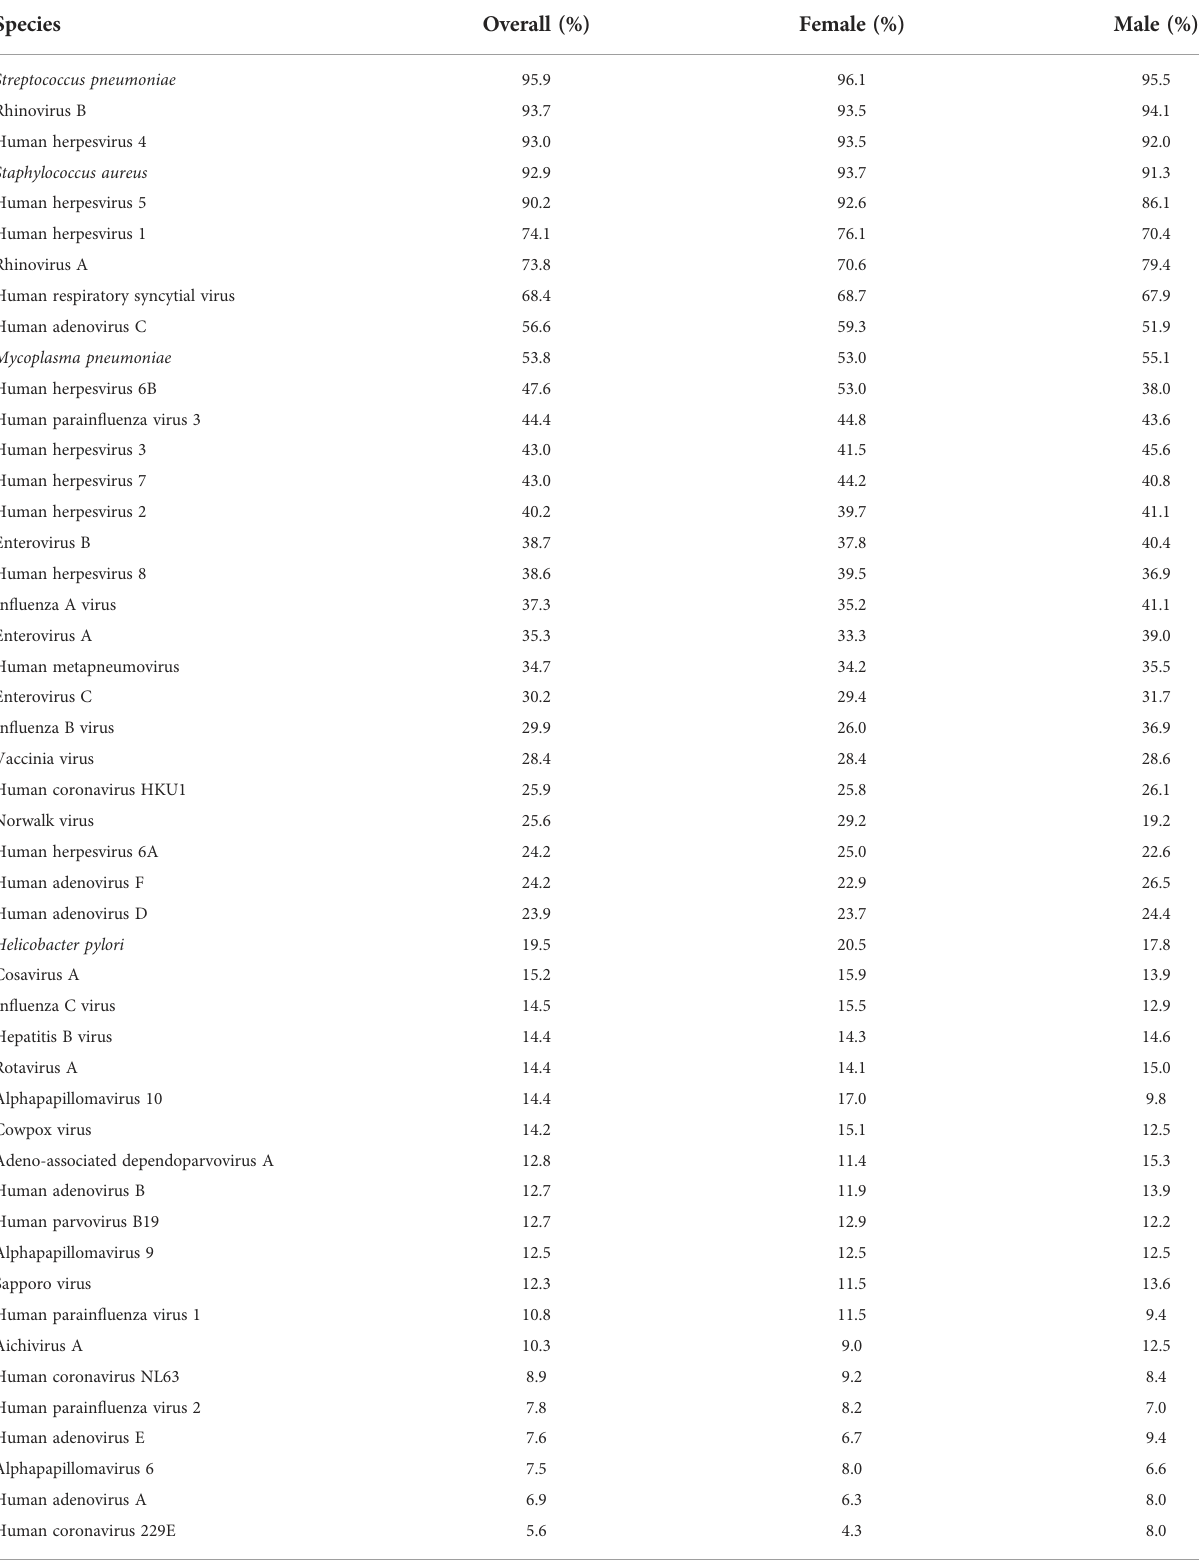
TABLE 2 Frequently detected antimicrobial antibody responses.